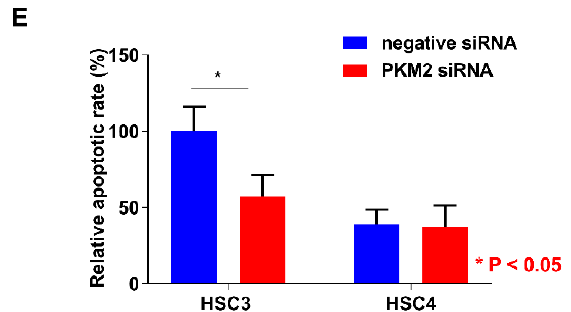
Figure 3. In vitro analysis of pyruvate kinase M2 (PKM2) in HSC3 and HSC4 cells. ( A ) Expression levels of PKM1 and PKM2 in HSC3 and HSC4 cells. GAPDH expression levels represent internal controls. ( B ) Effect of negative or PKM2 siRNA on PKM2 and GAPDH expression in HSC3 and HSC4 cells. Numbers below the panels of immunoblotting are the semiquantified protein expression level. ( C – E ) Effects of PKM2 short interfering RNA (siRNA) transfection on cell growth ( C ), invasion ( D ), and apoptosis induction ( E ) in HSC3 and HSC4 cells. Error bars indicate standard deviations (SDs). RQ: relative quantification.